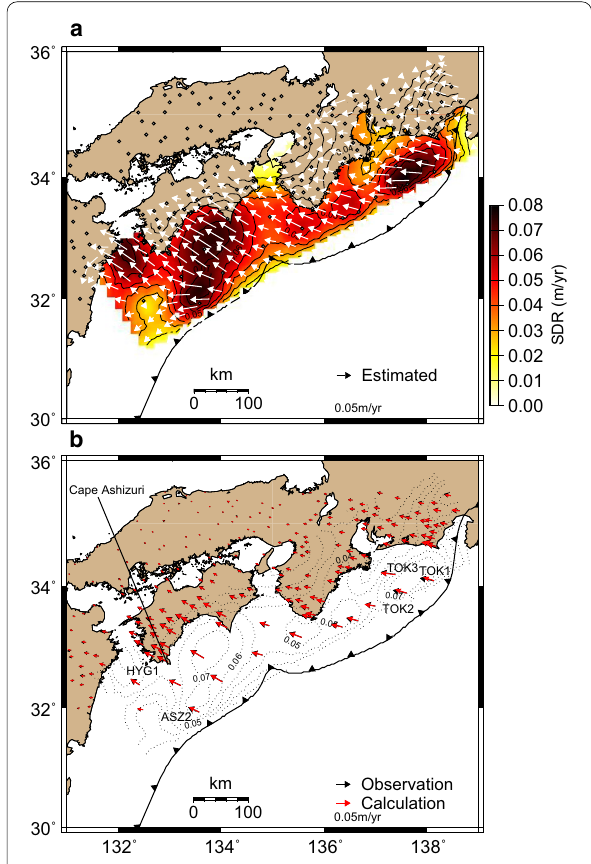
Fig. 7 SDR distribution estimated by Yokota et al. (2016) a Color contour and vectors of estimated SDR. The white dots denote the location of the observation. b Comparison of observed and calculated velocity in the observation stations. Dotted contour lines denote the norm of the estimated